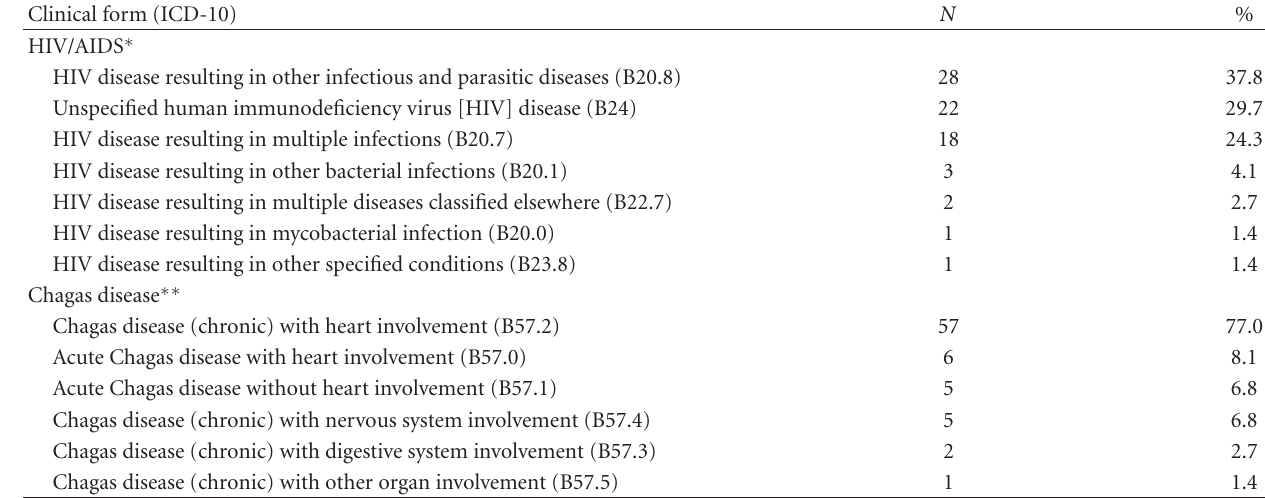
Table 2: Distribution of deaths related to Chagas disease and HIV/AIDS, according to clinical presentation, Brazil, from 1999 to 2007 ( n =